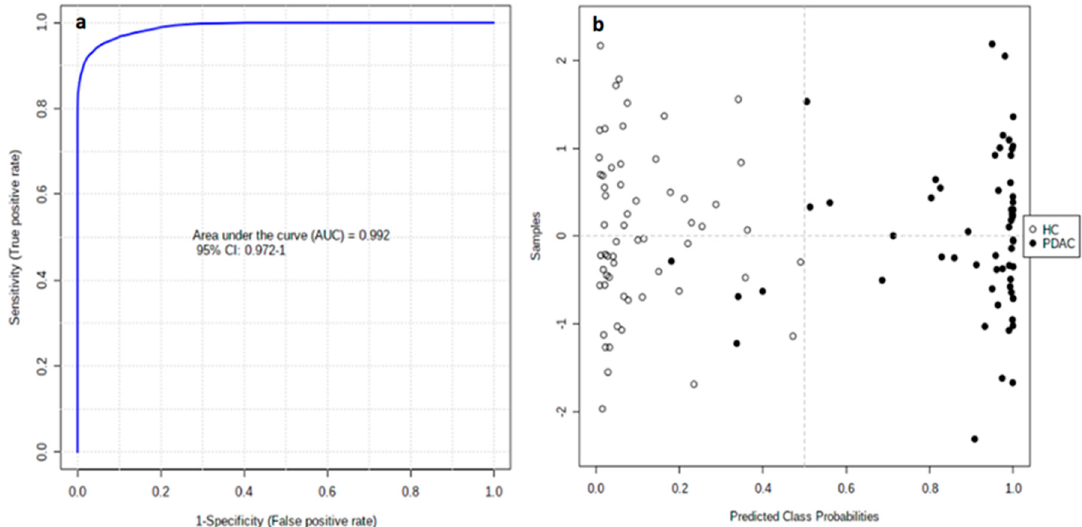
Figure 3. ROC curve for the nine-biomarker panel; 100 cross-validations were performed, and the results were averaged to generate the plot ( a ). Average of predicted class probabilities for each sample in 100 cross-validations. Given that the algorithm uses a balanced subsampling approach, the classification boundary is located at the center (x = 0.5, dotted line) ( b ).